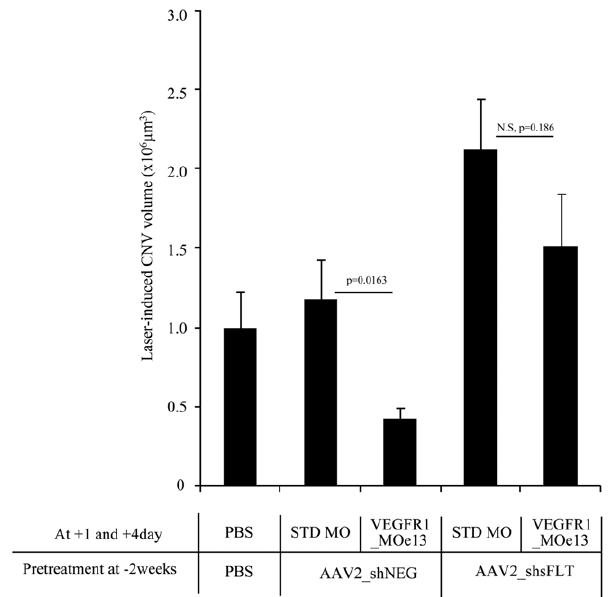
Figure 4. RNAi targeting sFlt-1 rescues the neovascular phenotype response to laser injury. Murine eyes were treated with PBS, AAV2_shNEG or AAV2_shsFLT. After 2 weeks, laser photo- coagulation was performed. On 1 day and 4 day after photocoagula- tion, PBS Standard_MO or VEGFR1_MOe13 were injected. Error bar is S.E.M.